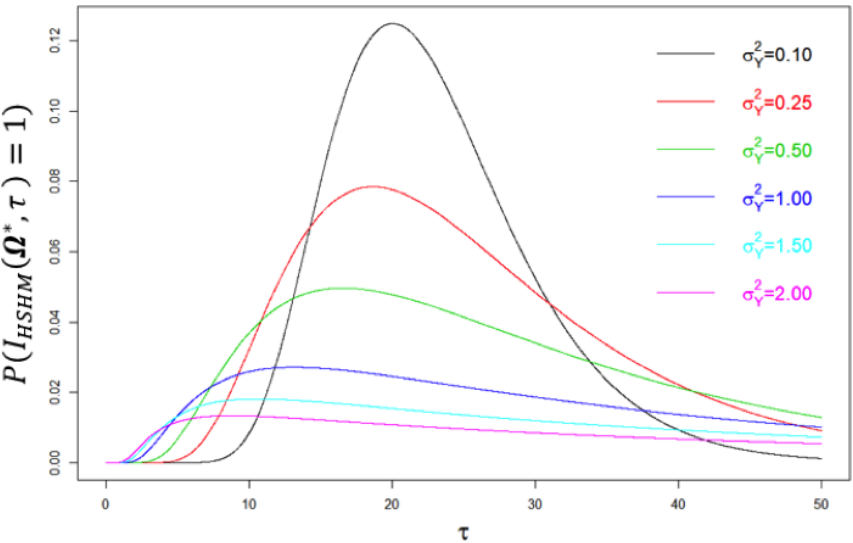
Figure 4. Dependence of P(I HSHM ((cid:127) ∗ ,τ) = 1 ) on time ( τ ) and on the level of spatial variability of the log-hydraulic conductivity ( σ 2